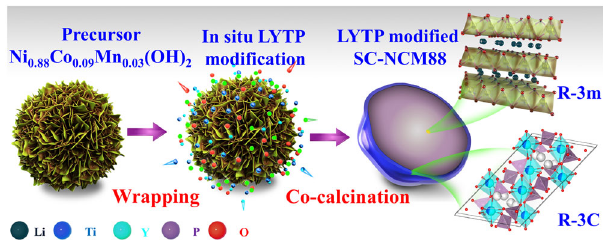
Fig. 1 LYTP@SC-NCM88 synthesis process. Schematic illustration of the synthesis method for LYTP-modi fi ed SC-NCM88